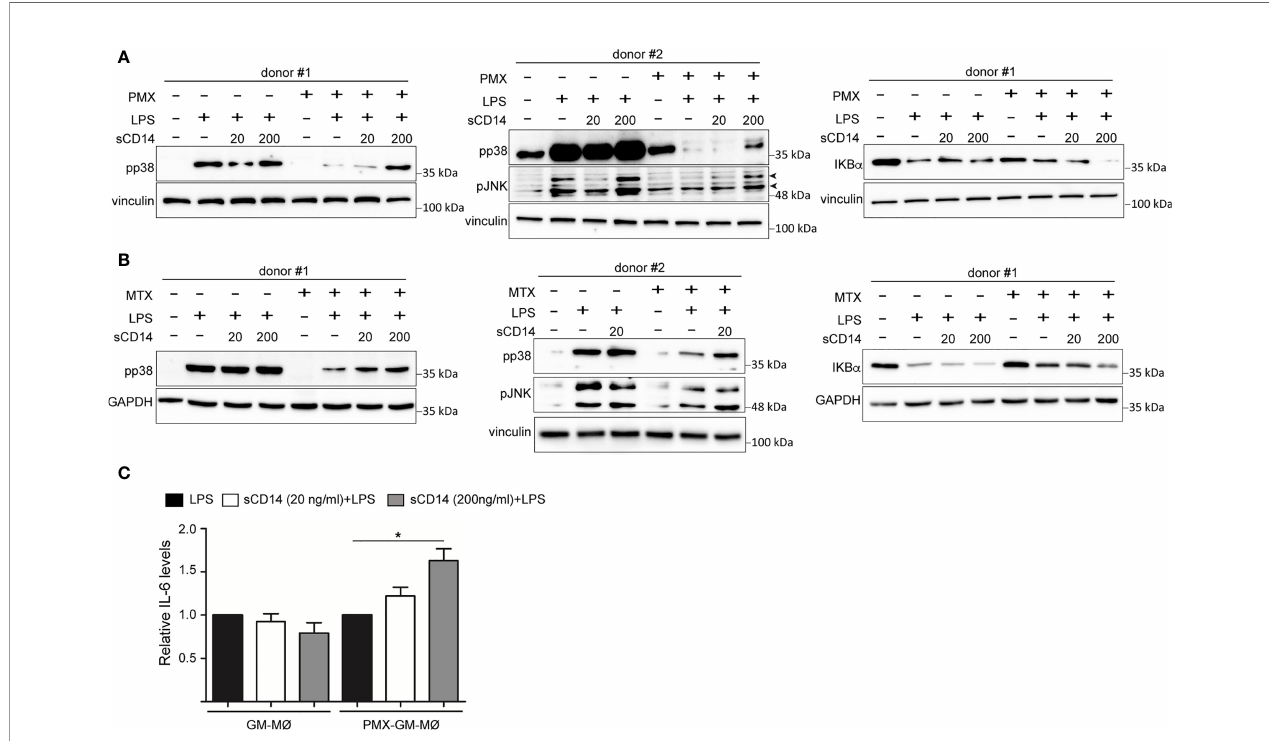
FIGURE 6 | sCD14 restores p38 and JNK activation and IL-6 production in LPS-treated PMX-GM-MØ. Immunoblot analysis of pp38, pJNK, and I k B a by GM-MØ and PMX-GM-MØ (A) or MTX-GM-MØ (B) challenged with LPS in the absence or presence of 20 ng/ml (20) or 200 ng/ml (200) of sCD14 for 15 min (pp38, pJNK) and 30 min (I k B a ). The experiment was performed in four independent donors, and two of them are shown. The signal in pp38 in donor #2 (A) is saturated for better detection of lane 8 (sCD14 200) in PMX-GM-MØ. Molecular weight markers are indicated. Arrowheads indicate the protein of interest. (C) Production of IL-6 by GM-MØ or PMX-GM-MØ challenged with LPS in the absence or presence of 20 or 200 ng/ml of sCD14 for 3 h, as determined by ELISA. The experiment was performed in four independent donors, and the relative production of IL-6 is shown (* p < 0.05). LPS, lipopolysaccharide; PMX, pemetrexed; sCD14, soluble